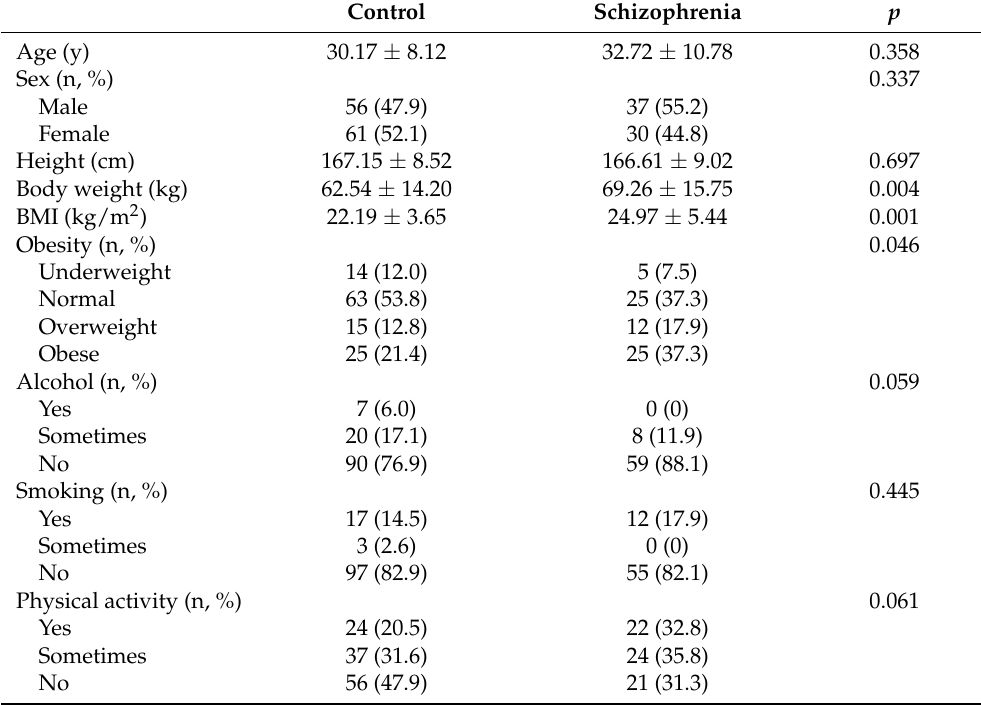
Table 2. Participant characteristics.